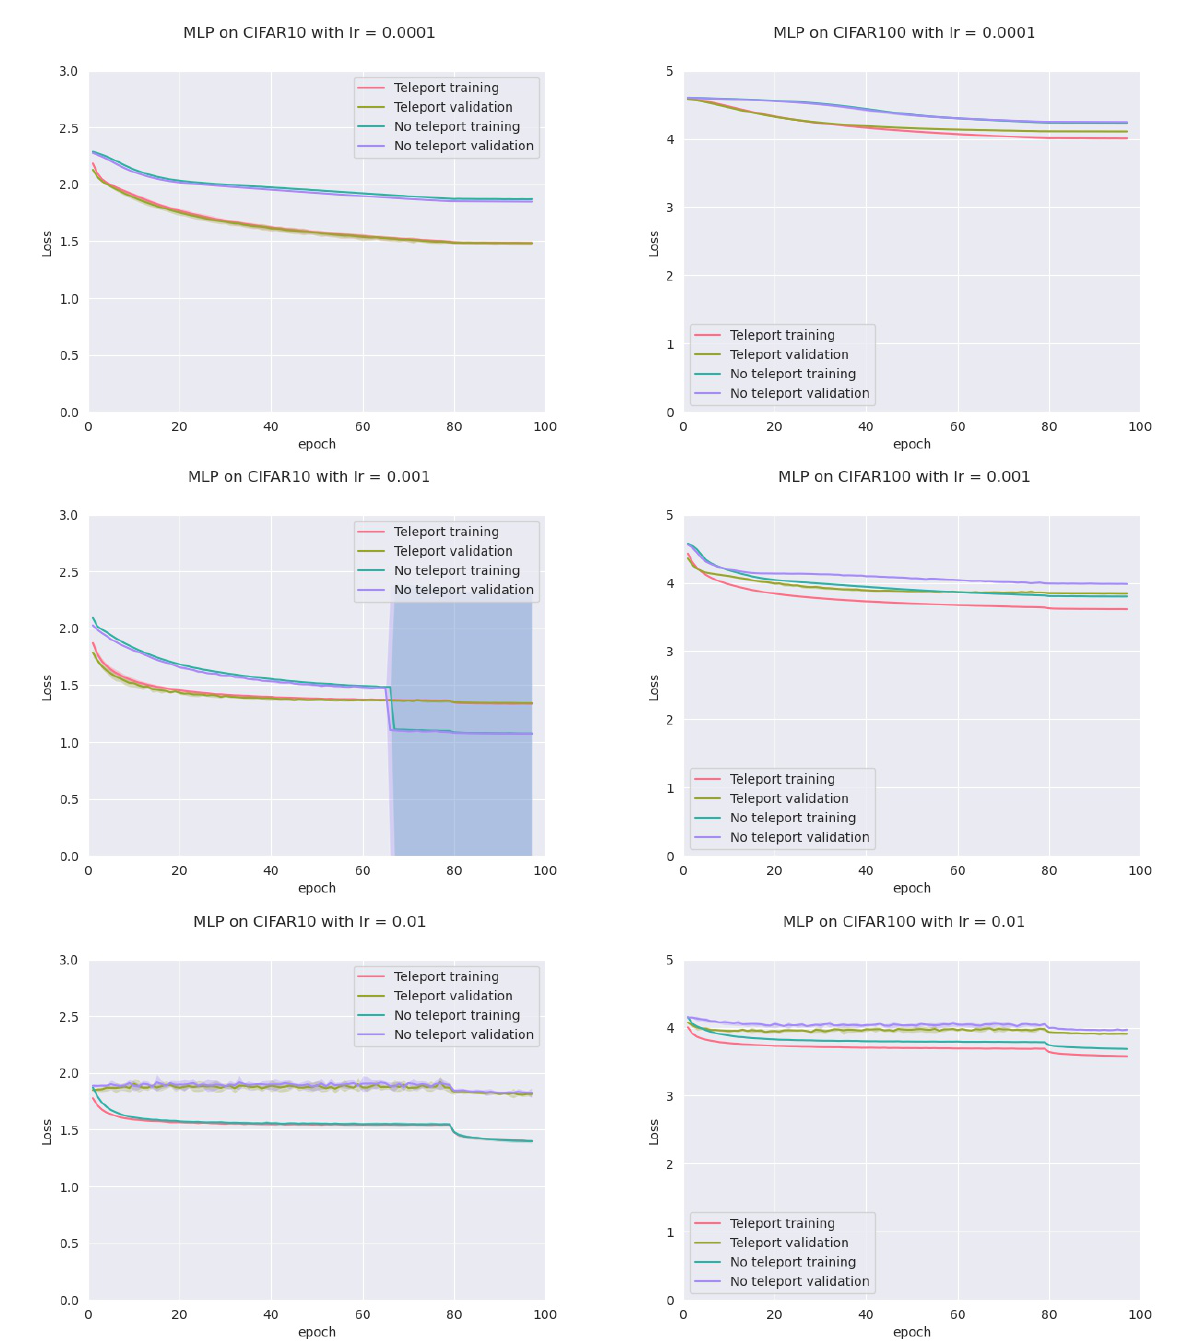
Figure 7. Average loss of MLPs with ELU activation function on CIFAR10 ( left ) and Tanh on CIFAR100 ( right ) over 5 experiments for each, with and without teleportation, at the beginning of the training with CoB of 0.9. Learning rate increases from top to bottom rows. We also show a shadow around the average curves at two times the standard deviation over the five